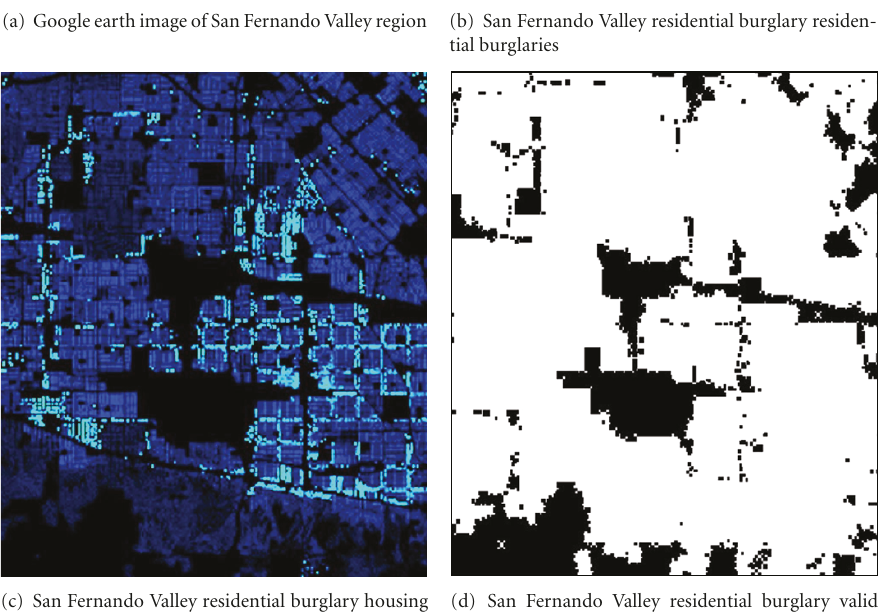
Figure 10: These figures are for the San Fernando Valley residential burglary data. In (a), we have the aerial image of the region we are considering, which is about 16km by 18 km. Figure (b) shows the residential burglaries of the region. Figure (c) gives the housing density for the San Fernando Valley. We show the valid region we obtained from the housing density in figure (d).